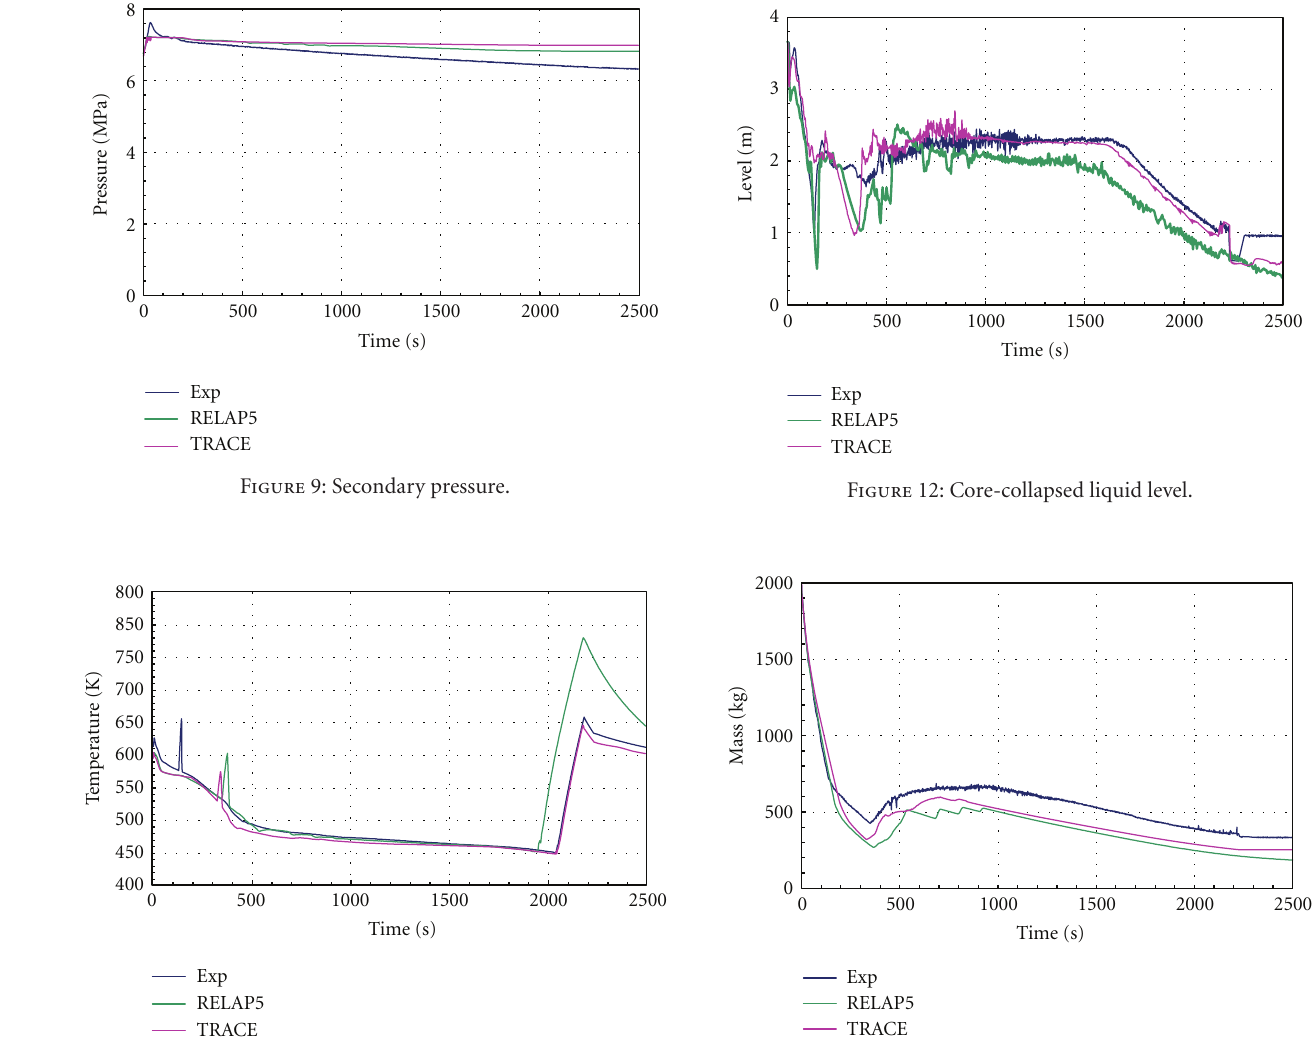
Figure 13: Primary circuit total